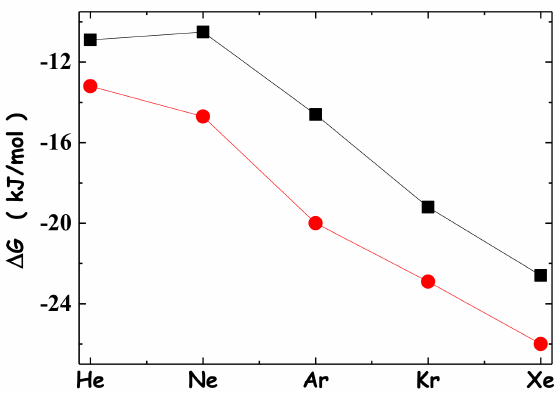
Figure 2. Experimental ∆ G(binding) values of noble gases to cucurbit[5]uril, measured via NMR at 22 ◦ C (black filled squares) [47], contrasted with minus the ∆ G C values for noble gases in water, calculated via classic SPT analytical formulas, and listed in column eight of Table 1 (red filled